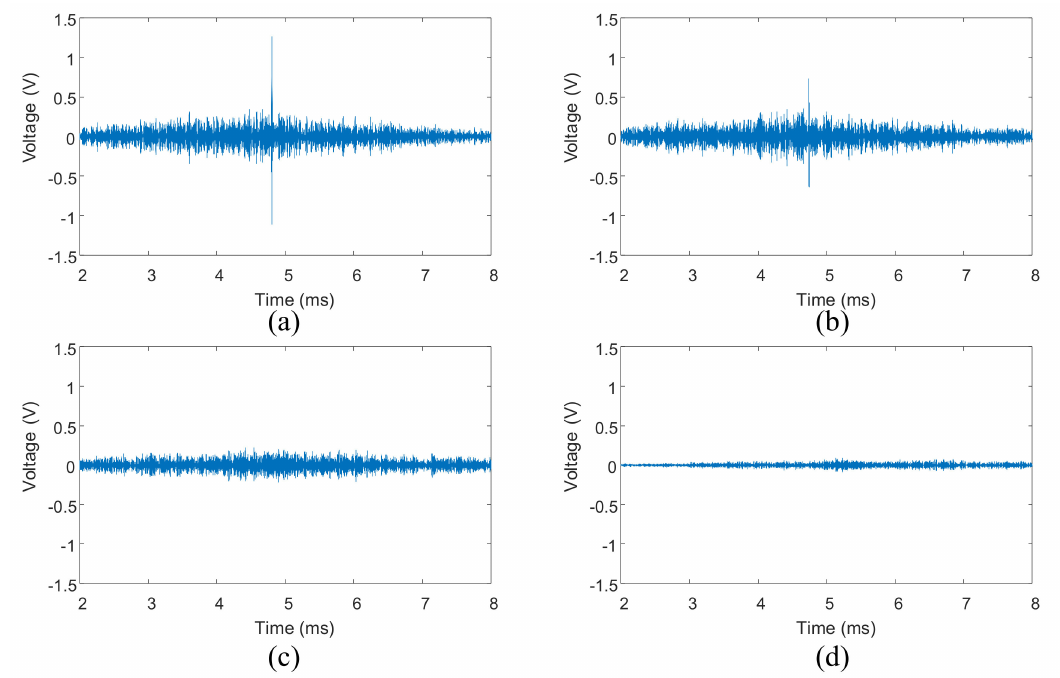
Figure 11. Reconstructed signals using VTR method acquired from four-bolt structure: ( a ) reconstructed signal with 8 Nm torque of bolt 2; ( b ) reconstructed signal with 1 Nm torque of bolt 2; ( c ) reconstructed signal under loosening case 5; ( d ) reconstructed signal under loosening case